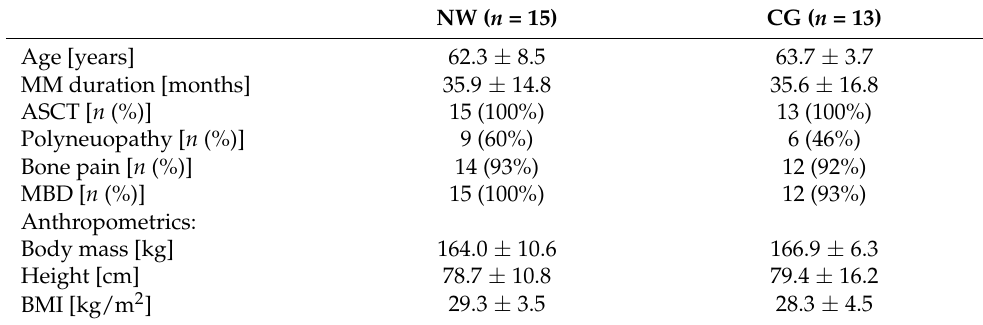
Table 1. Study group characteristics.